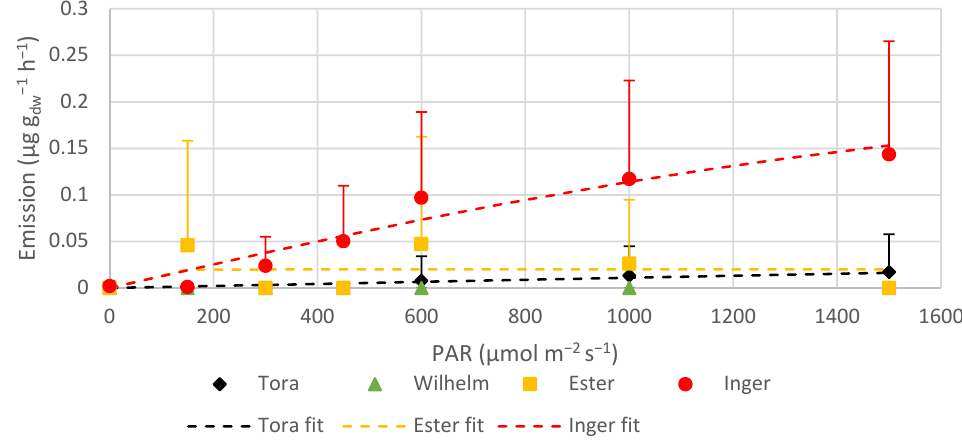
Figure 9. The light response of caryophyllene (µg g dw − 1 h − 1 , mean + standard deviation, n = 8) to different PAR values (µmol m − 2 s − 1 ) for the Salix varieties.